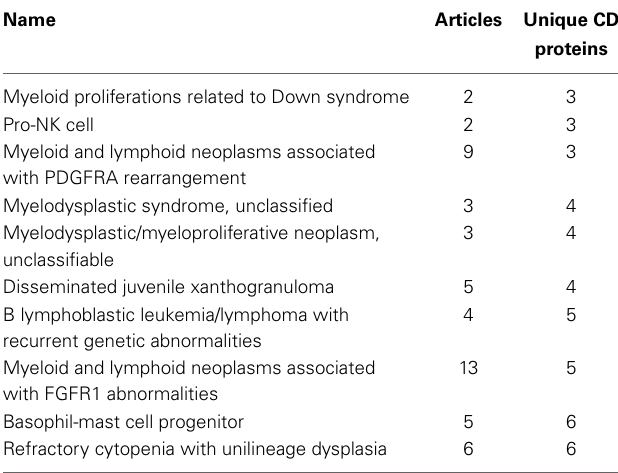
Table 1 | Ten best characterized cell types, as judged by available CD molecule data in the primary literature.